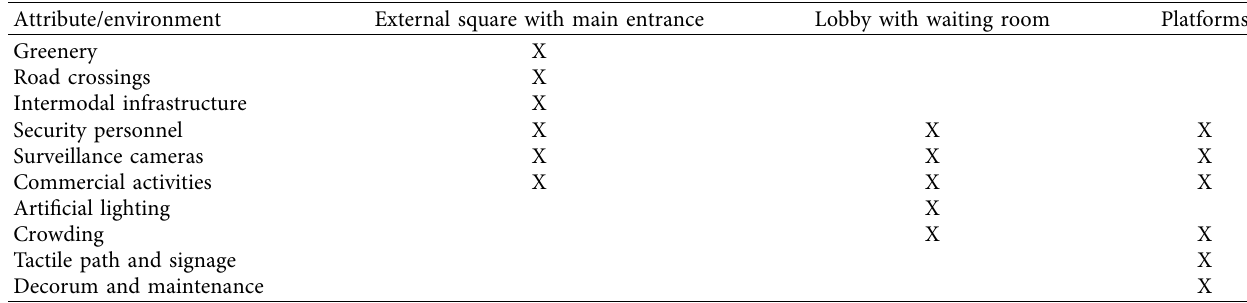
Table 1: Design of the